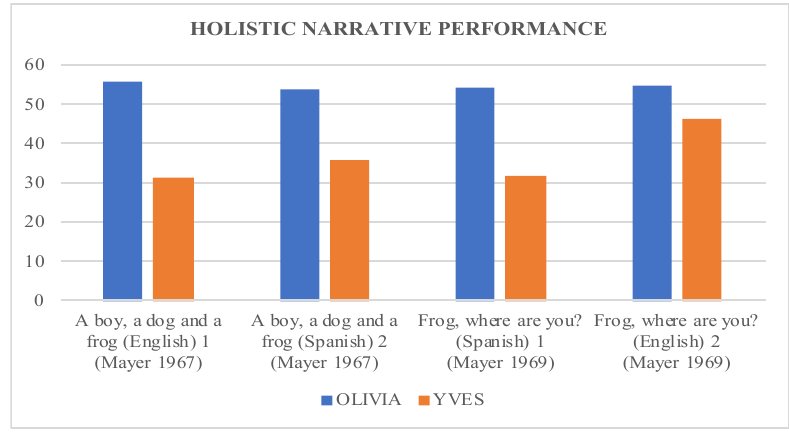
Figure 1. Holistic scores for Olivia and Yves’ narrative performance.